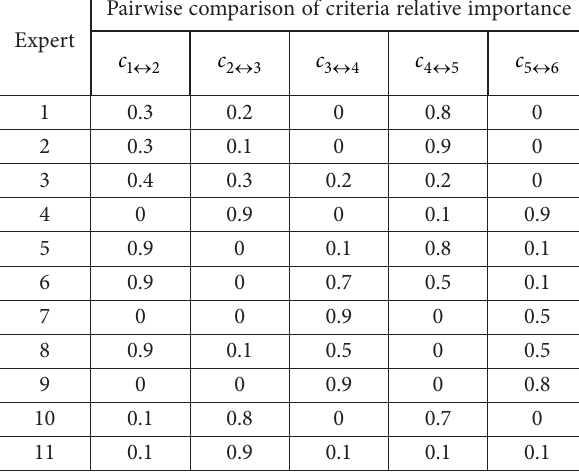
Table 3. Peer review of the relative importance of the criteria